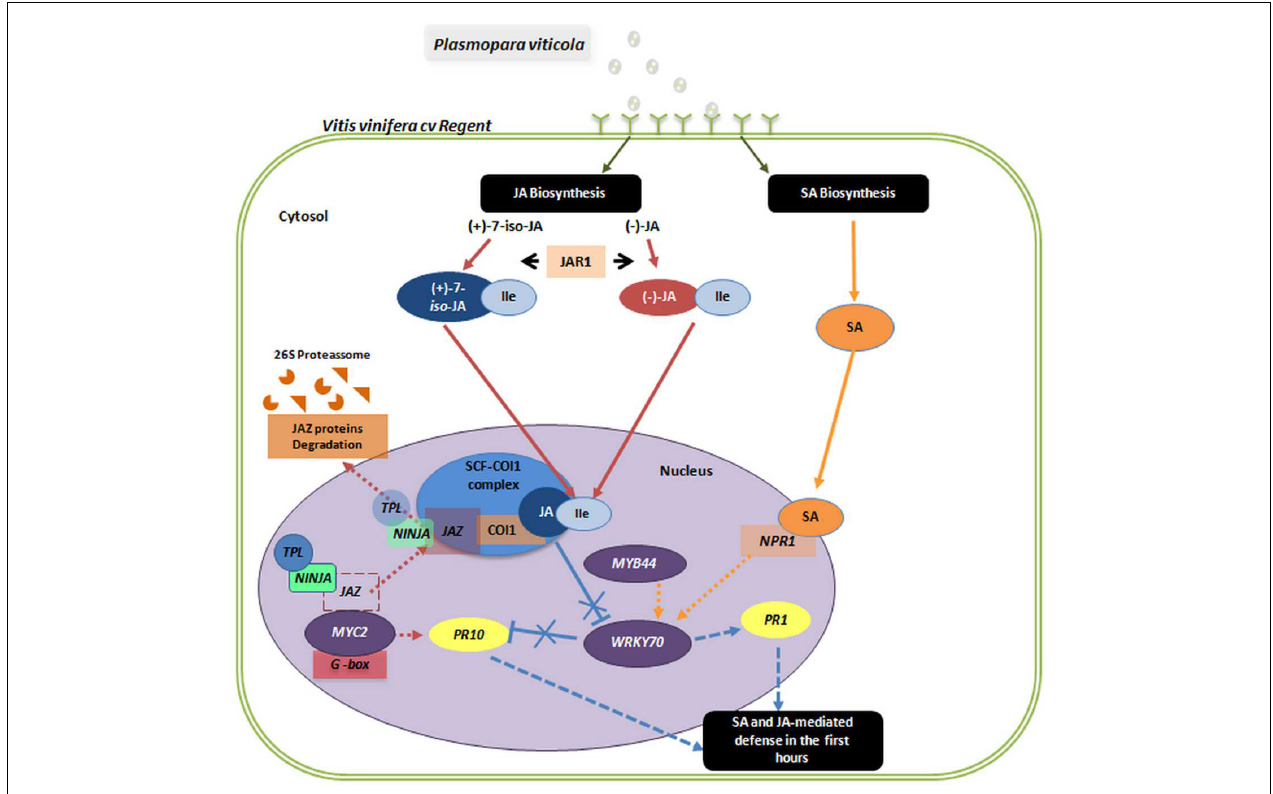
FIGURE 1 | On the first hours after Plasmopara viticola inoculation, the levels of SA, JA, and JA-Ile increased in V. vinifera cv. Regent relatively to mock inoculated control plants. Rapid accumulation of bioactive JA-Ile promotes SCF-COI1 mediated ubiquitination and subsequent degradation of JAZ proteins and corepressors TLP and NINJA via the 26S proteasome, relieving the transcription factors such as MYC2 and promoting the expression of JA-responsive genes such as PR10 . High levels of SA mediate a change in the cellular redox potential, resulting in the reduction of the NPR1 oligomer to its active monomeric form. Monomeric NPR1 is then translocated into the nucleus where it functions as a transcriptional co-activator of SA-responsive genes, such as PR-1 . Both the SA and JA signaling pathways seem to be simultaneously activated on the first hours of interaction. See text for details on the molecular processes underlying both JA- and SA-signaling. Solid lines indicate established accumulation and dashed lines suggested activities.